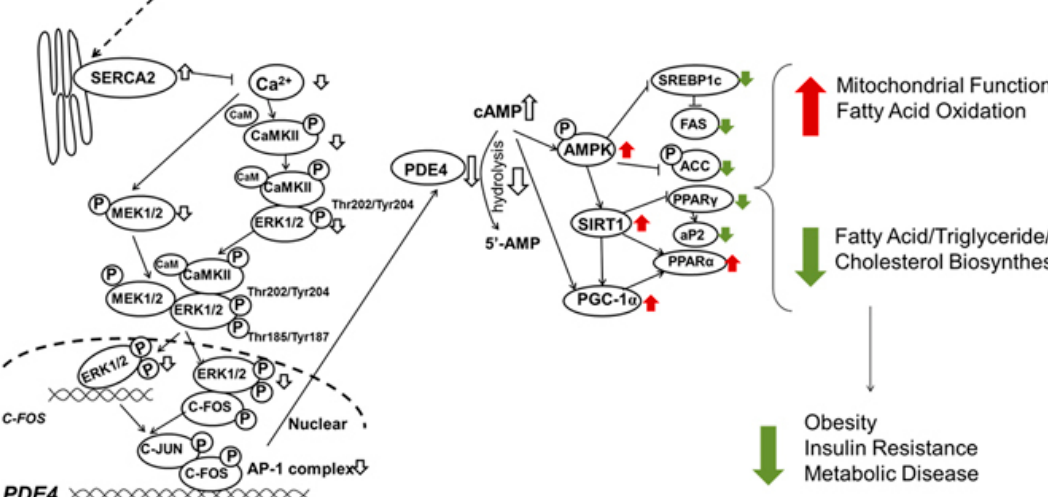
Figure 4. Proposed mechanism by which ubiquinol improves metabolic function and inhibits insulin resistance in KKAy mice (a mouse model of obesity and diabetes). Ubiquinol inhibited phosphorylation of CaMKII (Ca2+/calmodulin-dependent protein kinase II) in the liver resulting in inhibition of C-FOS transcriptional activity and inhibition of PDE4 gene expression. Increased cAMP increases AMPK (AMP-activated protein kinase) activity resulting in SIRT1 and PGC-1 α increased mitochondrial function and inhibition of lipid synthesis. (Adapted from Xu H. et al. 2017 [106] with permission).